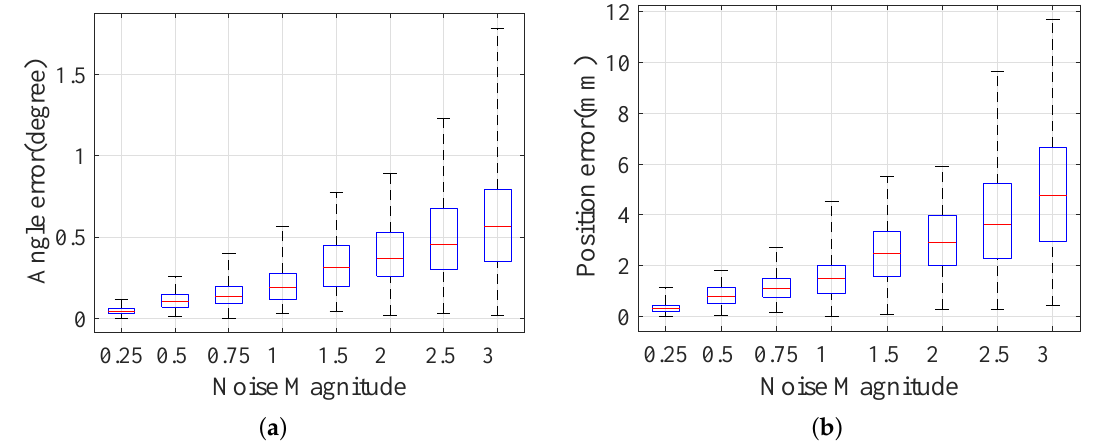
Figure 4. Error distribution under noise levels in the range of [0.25, 3.0]: ( a ) angular error of direction; ( b ) position error.